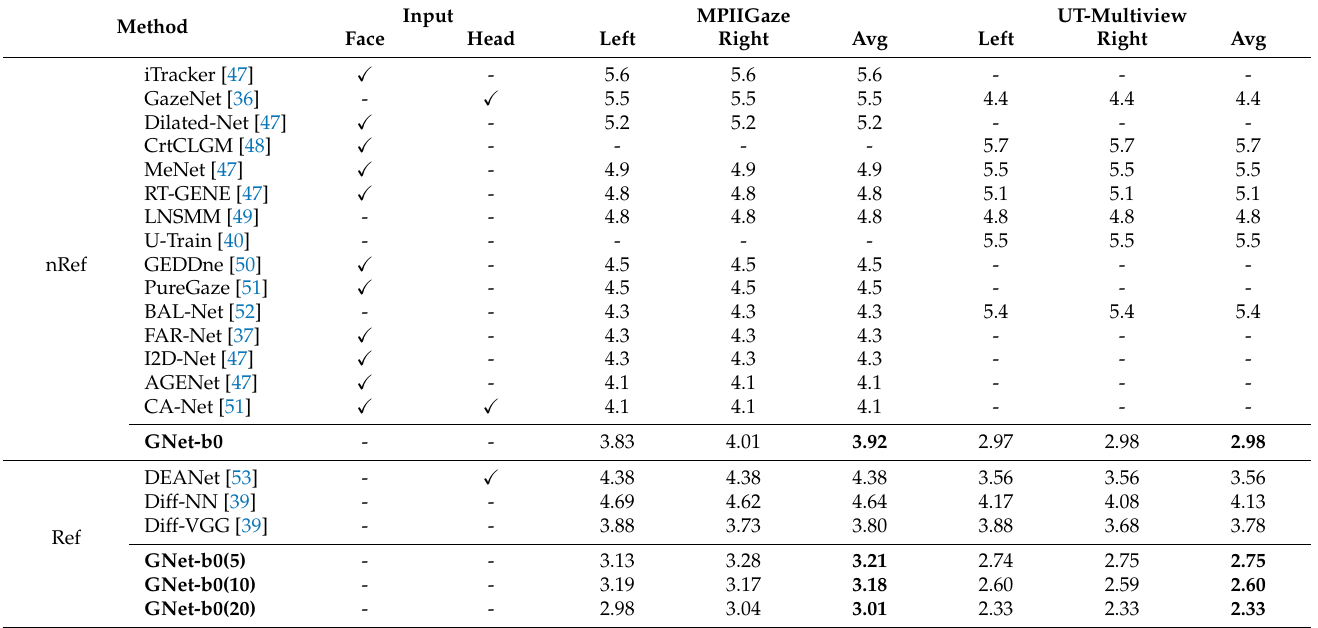
Table 2. A comparison of gaze estimation